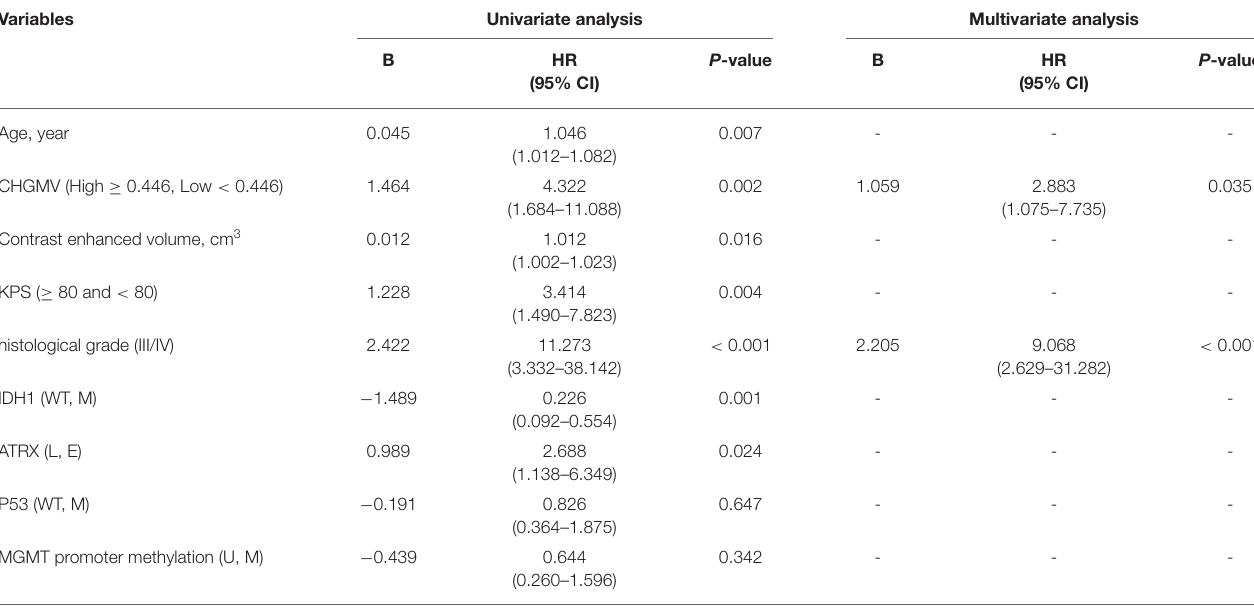
TABLE 4 | Univariate and multivariate Cox regression analysis of variables to predict OS.